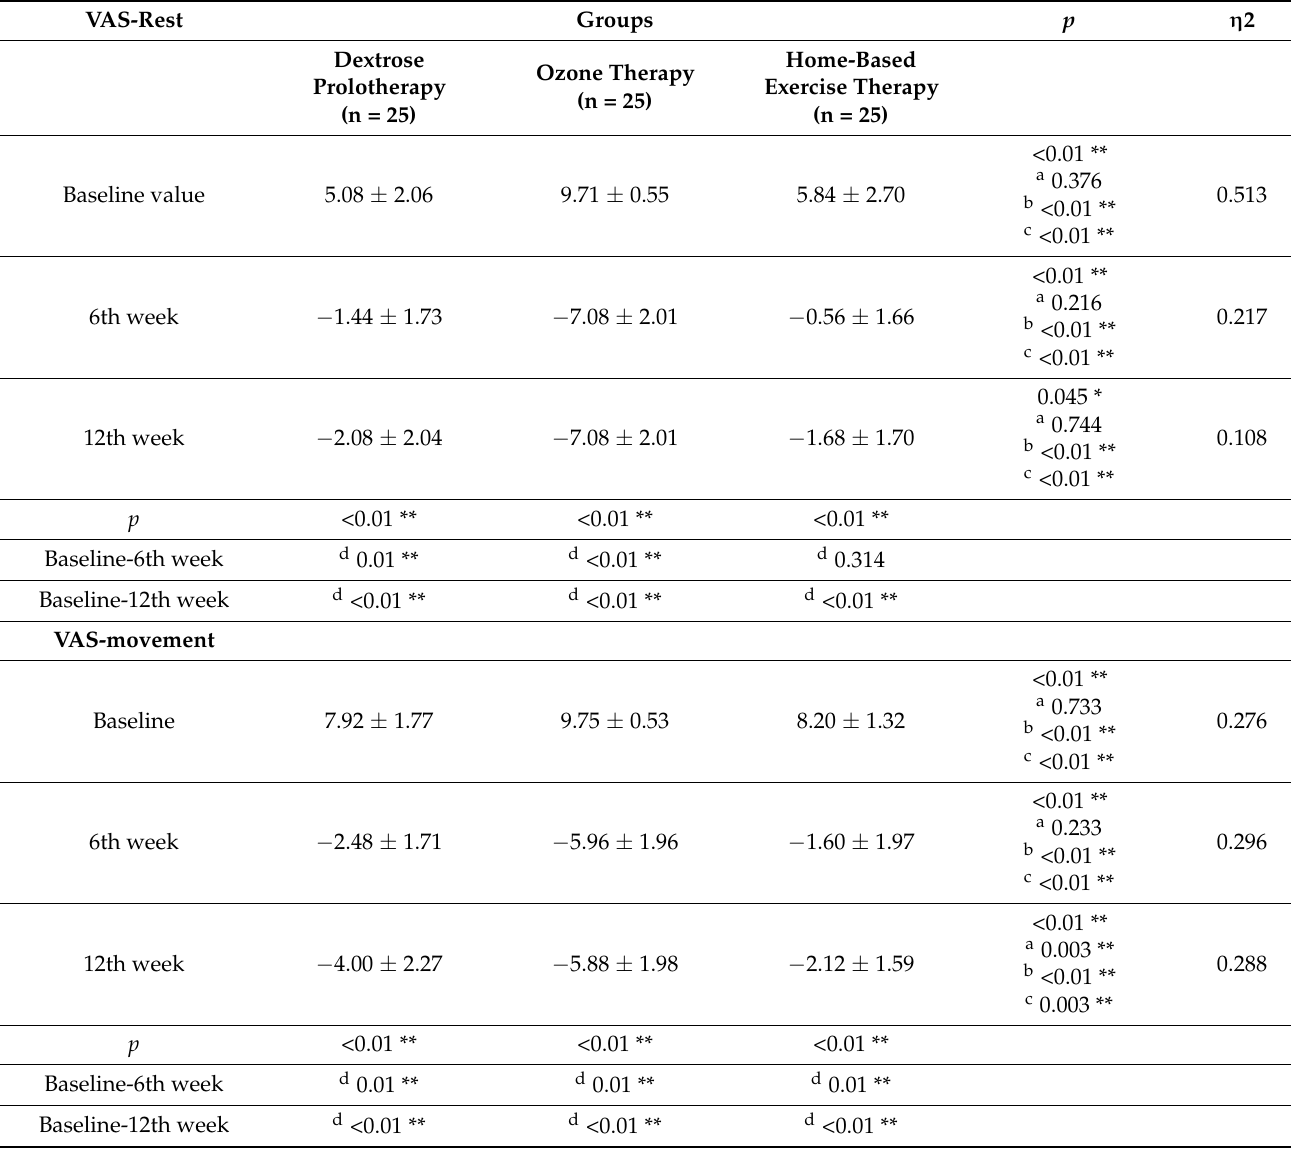
Table 2. VAS scores of groups and